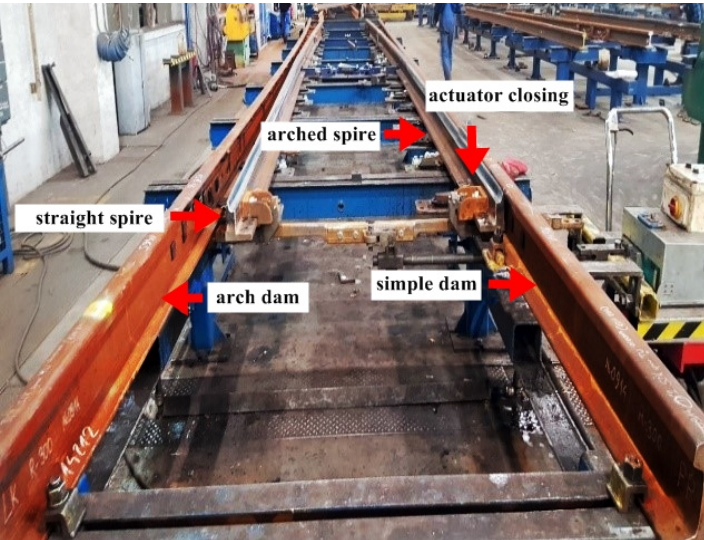
Figure 2. Railway switch. Source: own.